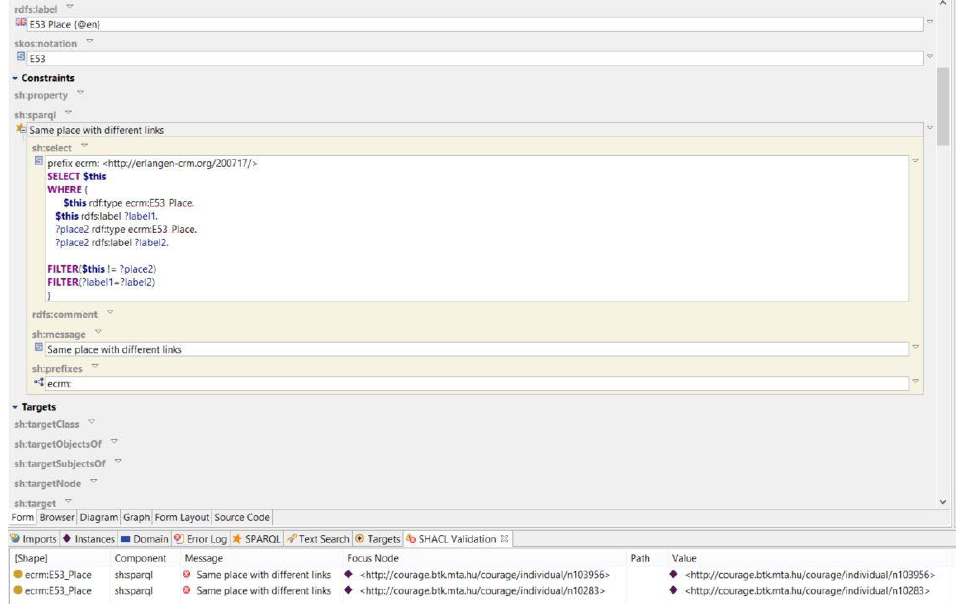
SHACL shapes using a user-friendly interface. In Figure 14, for example, we executed the SHACL shape, which was expressed with more complex conditions in a SPARQL query, to check whether there were duplicated places with different URIs. The error messages with detailed information (focus node, value) are displayed in the SHACL Validation tab.